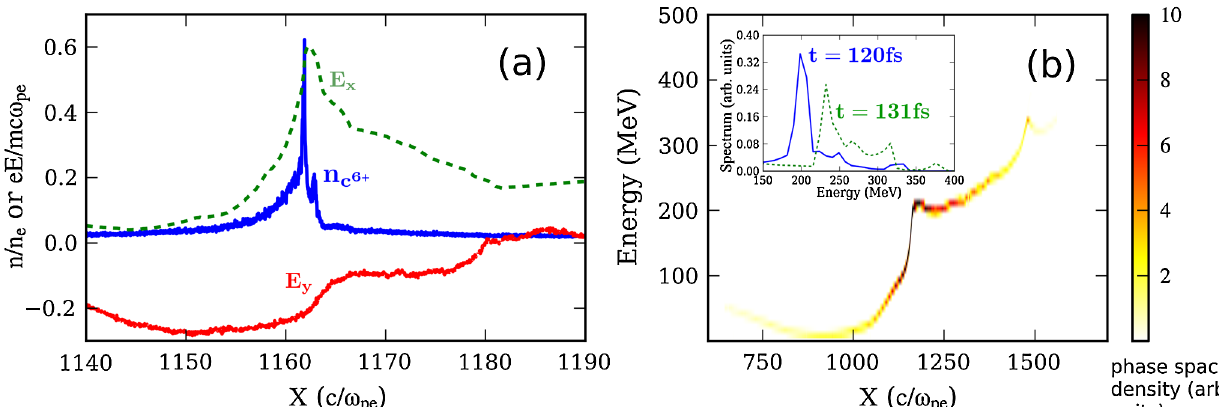
FIG. 1. 1D PIC simulation of the laser thin-foil interaction at the BOA stage. (a) The laser field (polarize in y and propagate from left to right in x ) has penetrated the target whose peak is at x ¼ 1161 c=! pe at t ¼ 120 fs . (b) Phase space of the C 6 þ ion at t ¼ 120 fs when BOA happens. The energy spectrum (inset) shows a quasimonoenergetic peak at 196 MeV and the FWHM is 21 MeV, corresponding to an energy spread of 10.7%. The energy spread evolves to > 30% at t ¼ 131 fs and the phase space develops a kink structure (not shown) as the result of the acceleration field E x shown in (a).